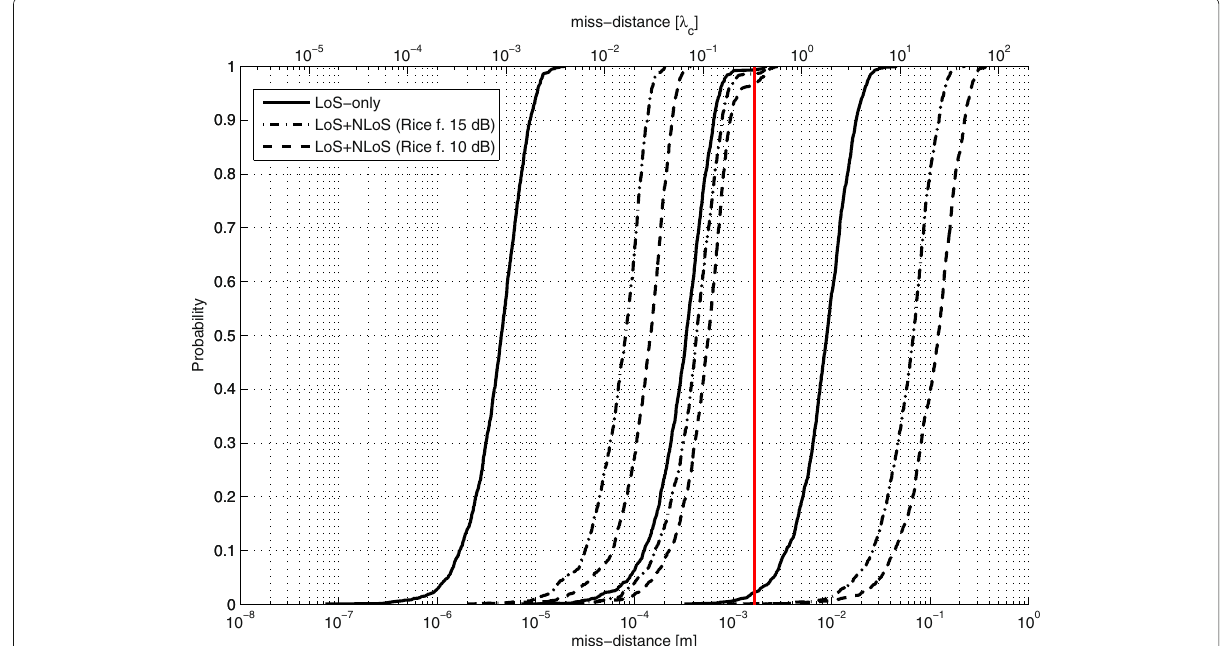
Fig. 22 CDF curves of localization errors for different stages and Rice factors for SNR 0 = 20